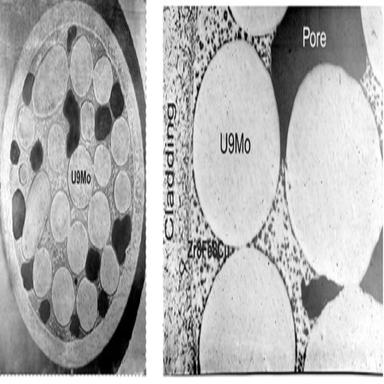
The U-9Mo fuel pin structure.